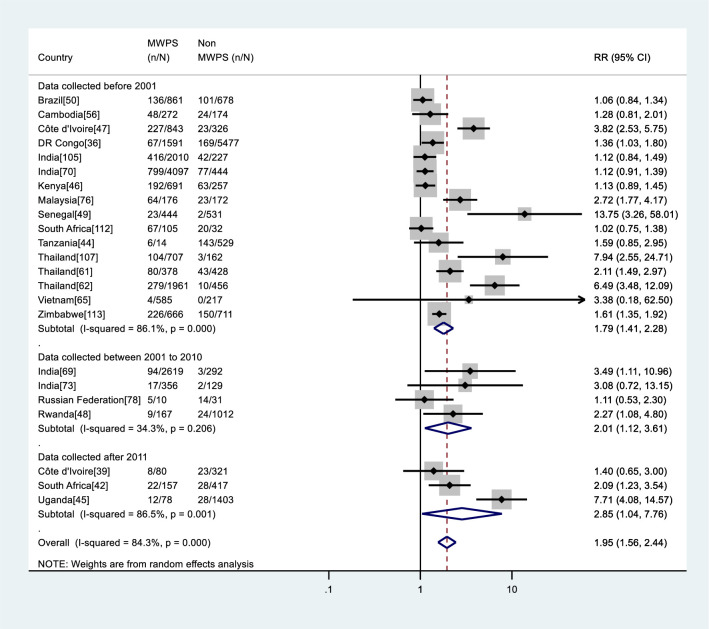
Meta-analysis of HIV risk in MWPS versus non-MWPS in LMICs by data collection period.RR: Relative risk, n: Number of HIV positive, N: Number of samples.